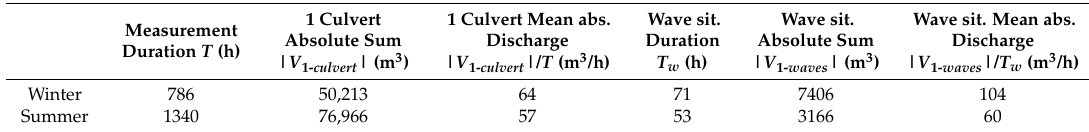
Table 7. Statistical values regarding the flow measured inside the flushing